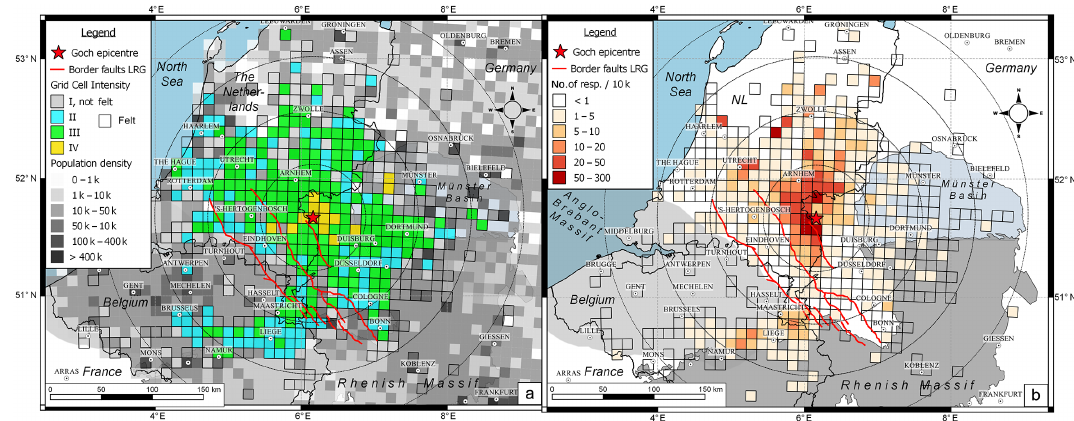
Figure 8. (a) Merged grid cell intensity map of the 2011 Goch earthquake overlaid on the population density grid cell map. Note the absence of macroseismic entries in the northern part of Belgium, despite its high population density. (b) Number of responses normalized for population density (no. of responses per 10000 people). On average the Goch event resulted in 9.8 responses per 10000 inhabitants, with 20 responses per 10000 in the epicentral cell and a maximum of 242 responses per 10000 in the cell 5km south of the epicentre. Circles represent 50, 100, 150 and 200km epicentral